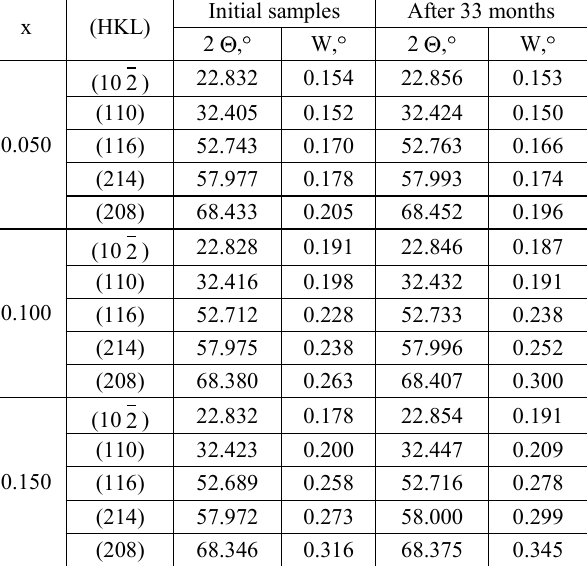
Fig. 1 . Magnetization (a) and Curie point (b) of manganites La 0.8-x Sr 0.2+x Mn 1-x Ti x O 3+ γ at different points in storage time:  – х = 0.050;  – х = 0.075;  – х = 0.100;  – х = 0.125;  – х =